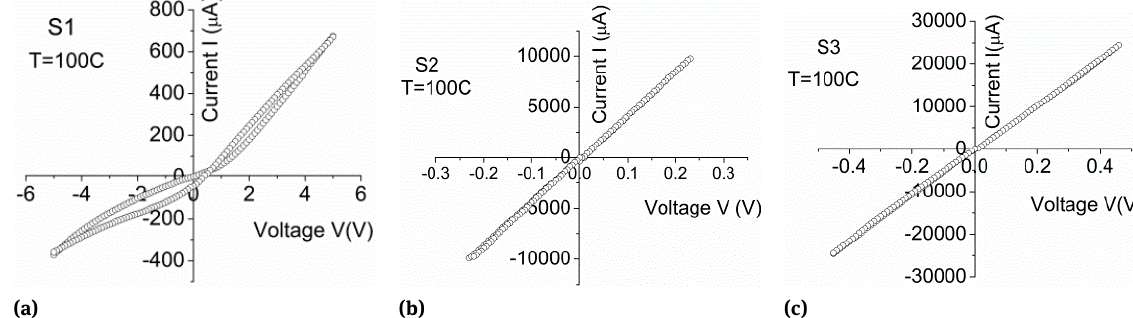
Figure 7: Nonlinear and linear I-V behavior for a) 5 wt% Fe 3 O 4 , b) 10 wt% Fe 3 O 4 , and c) 15 wt% Fe 3 O 4 .